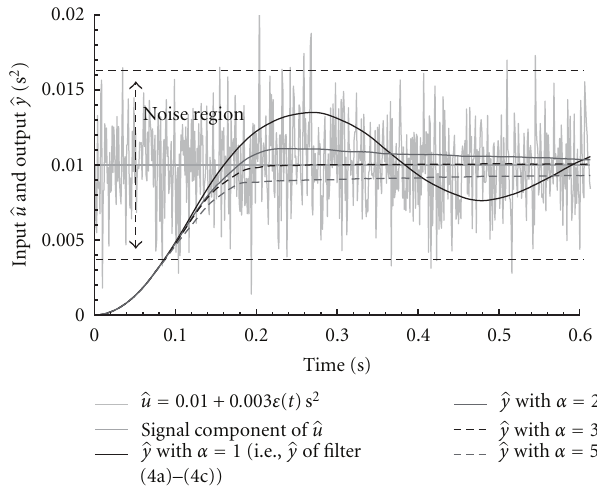
Figure 9: Time response of filter (1a)–(1c) with normalized input (cid:8) u ( t ) = 0 . 01 + 0 . 003 ε ( t )s 2 , which is a step input corrupted by white Gaussian noise. Here, the response of filter (1a)–(1c) with α = 1 refers to that of filter (4a)–(4c).